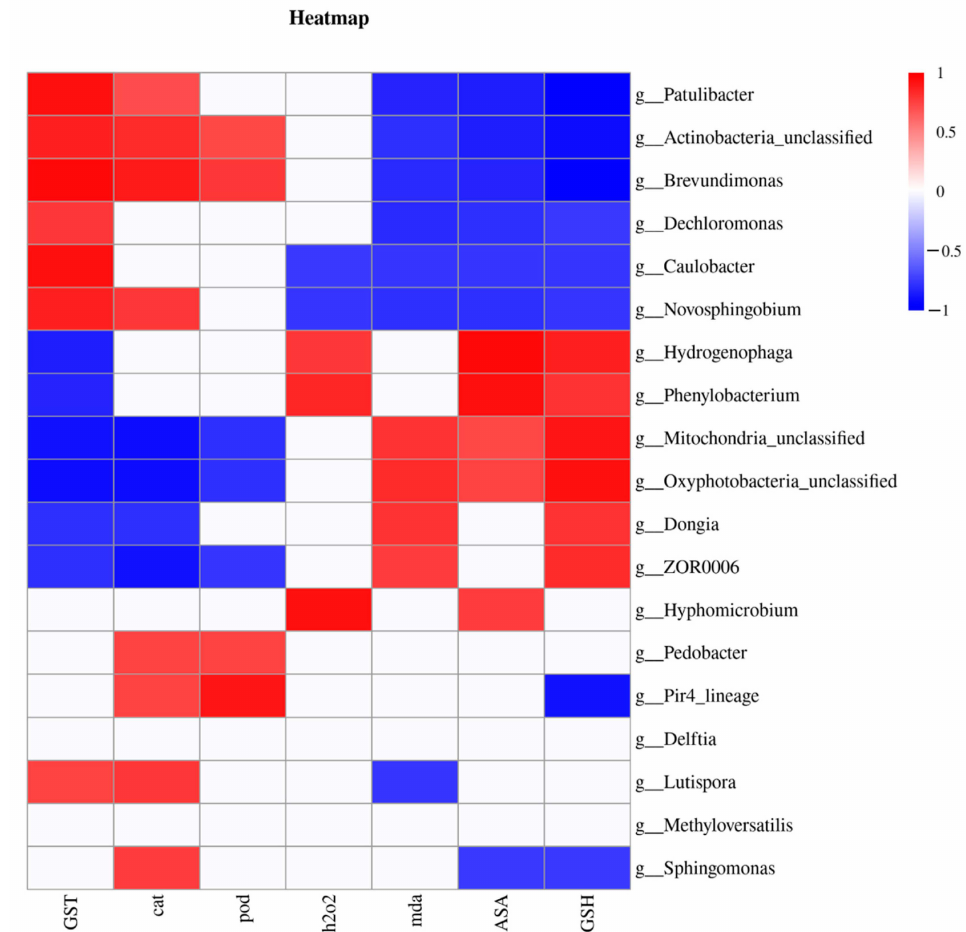
Figure 6. Correlation analysis of the larval gut microbiota (at the genus level) and physiological parameters in the H. cunea . Each square is filled with a color according to Pearson’s coefficient. Red represents a positive correlation (Z-test, p < 0.05); blue represents a negative correlation (Z-test, p < 0.05); and white represents a non-significant correlation (Z-test, p >